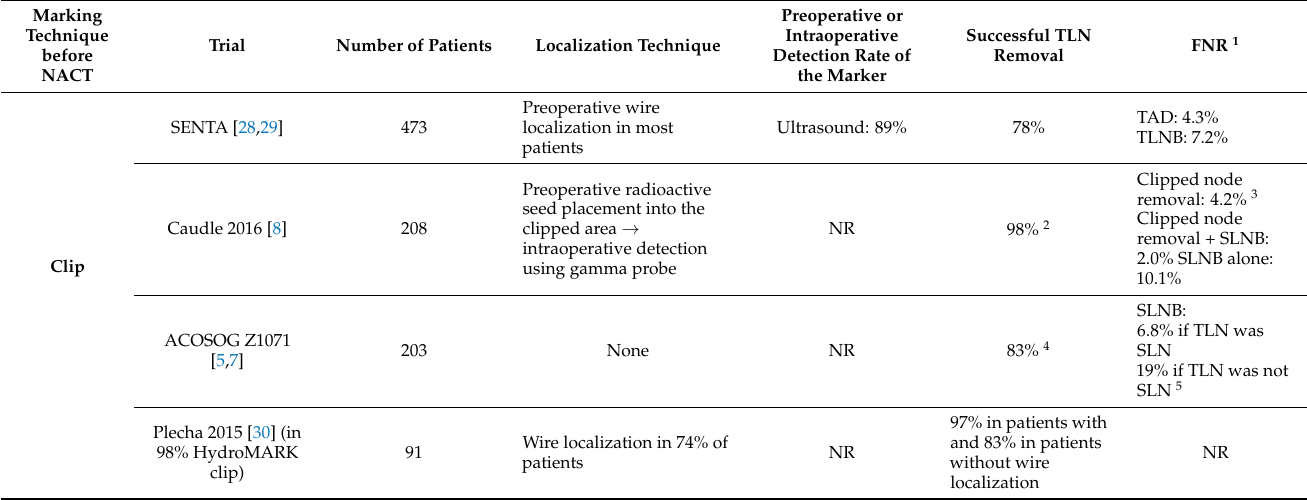
Table 5. Marking and localization methods for target lymph node retrieval in breast cancer patients undergoing neoadju- vant